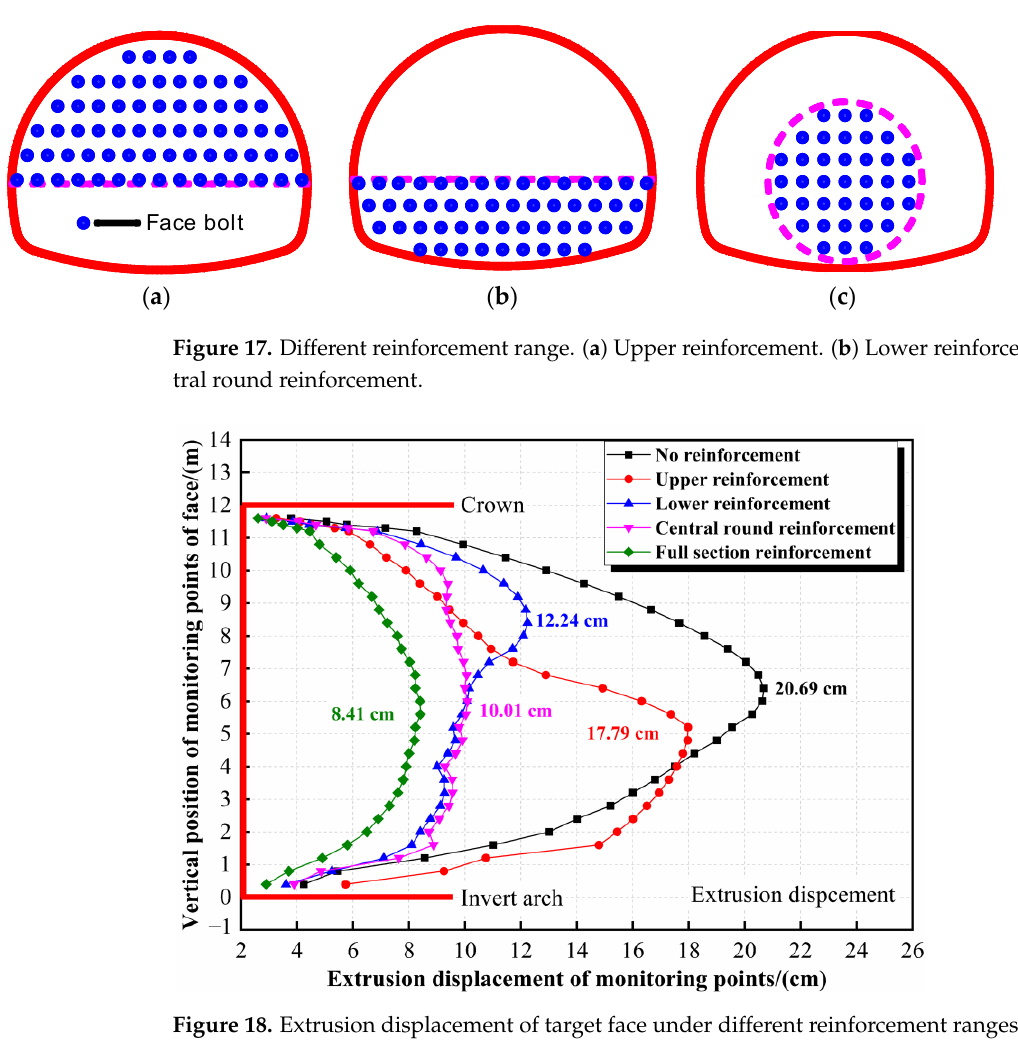
Figure 18. Extrusion displacement of target face under different reinforcement ranges.